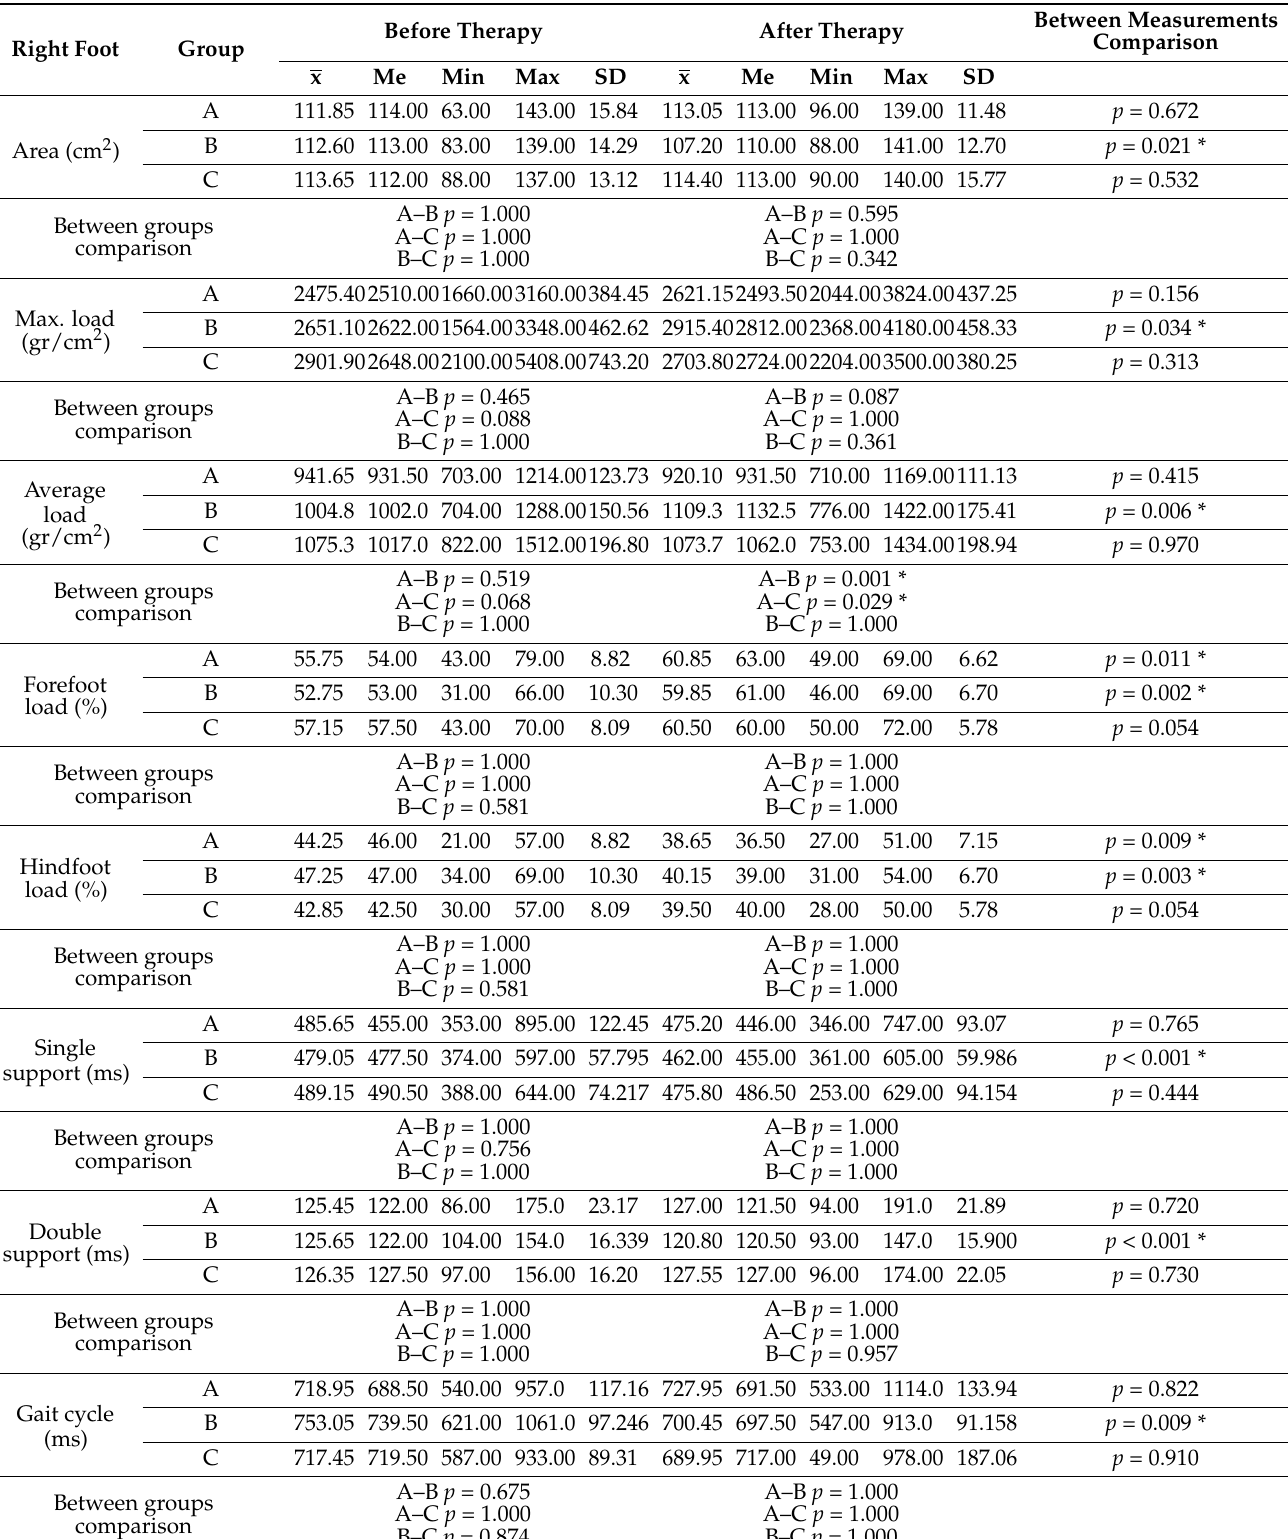
Table 5. Differences between selected right foot dynamic indicators in the individual groups before and after